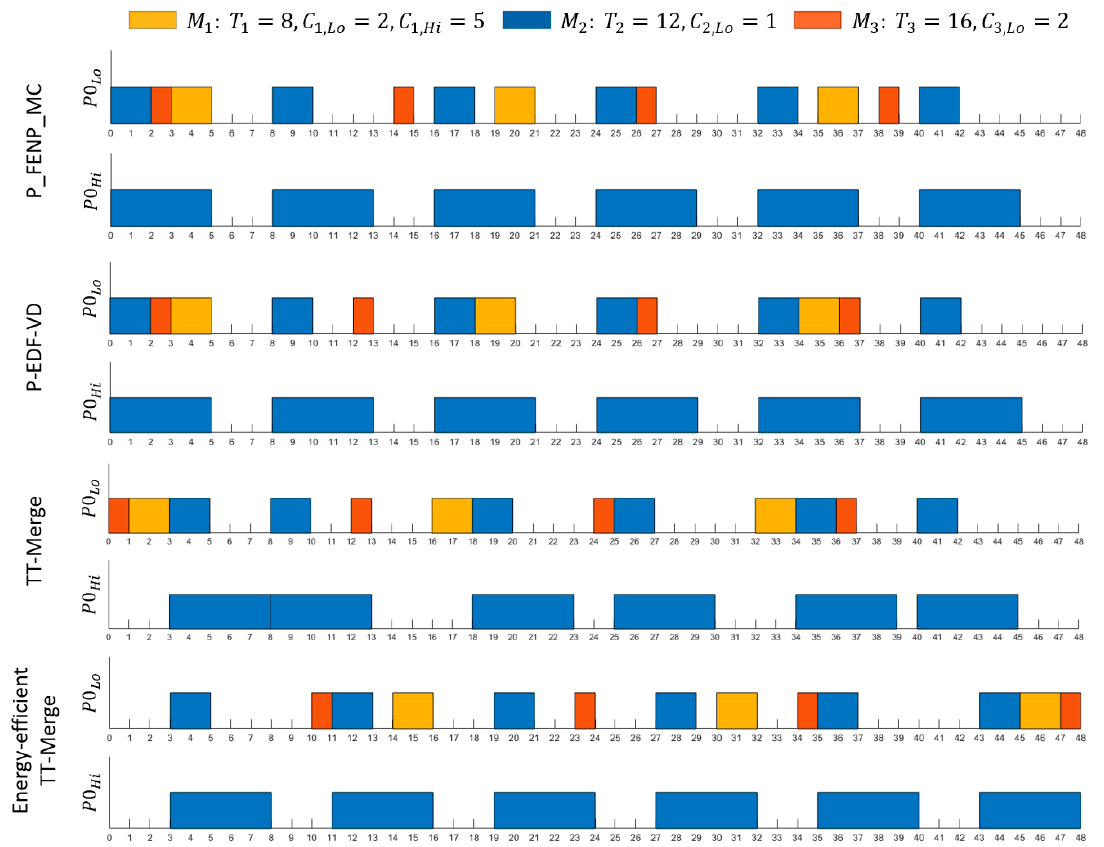
Figure 10. Scheduling of the task set example using four methods: Partitioned Fixed Execution Non- Preemptive Mixed Criticality (P_FENP_MC), Partitioned Earliest Deadline First with Virtual Deadlines (P-EDF-VD), a non-preemptive variant, Time-Triggered Merge (TT-Merge), and Energy- efficient Time-Triggered Merge (Energy-efficient TT-Merge).